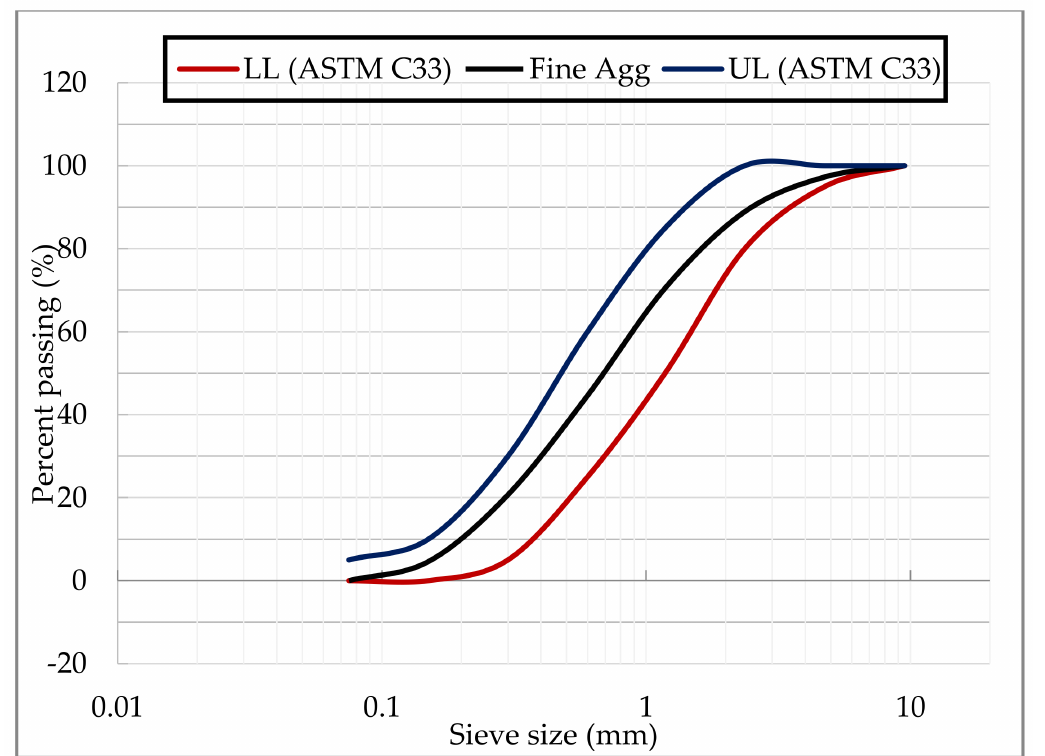
Figure 3. Particle Size Distribution of Fine